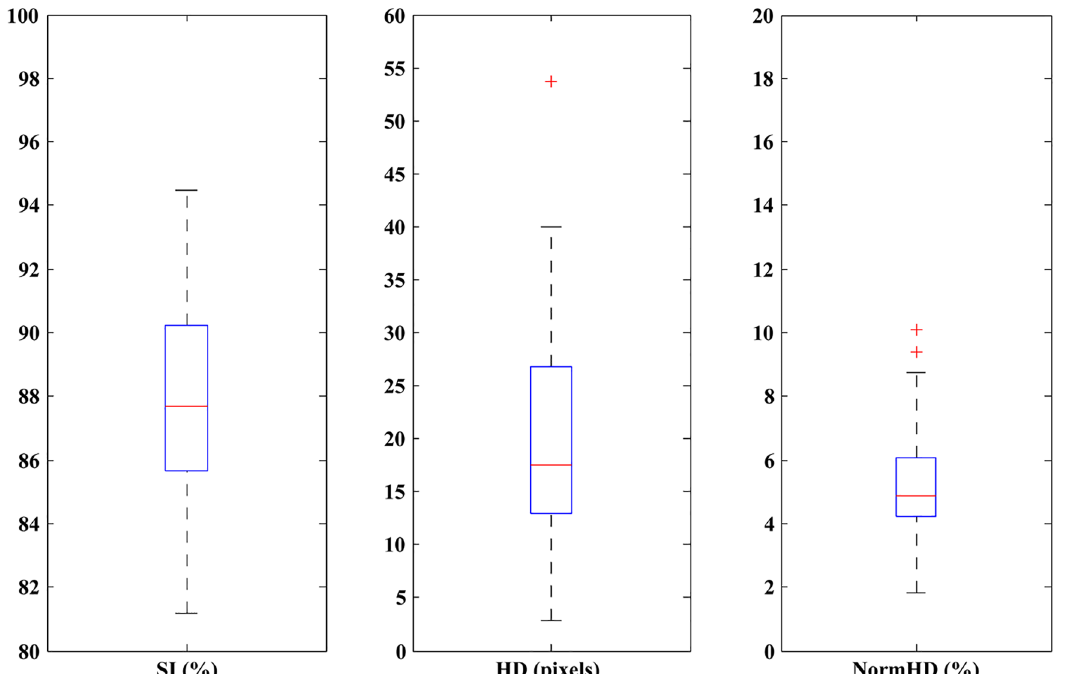
Fig 9. Boxplots of statistical results. Left: SI. Middle: HD. Right: NormHD.